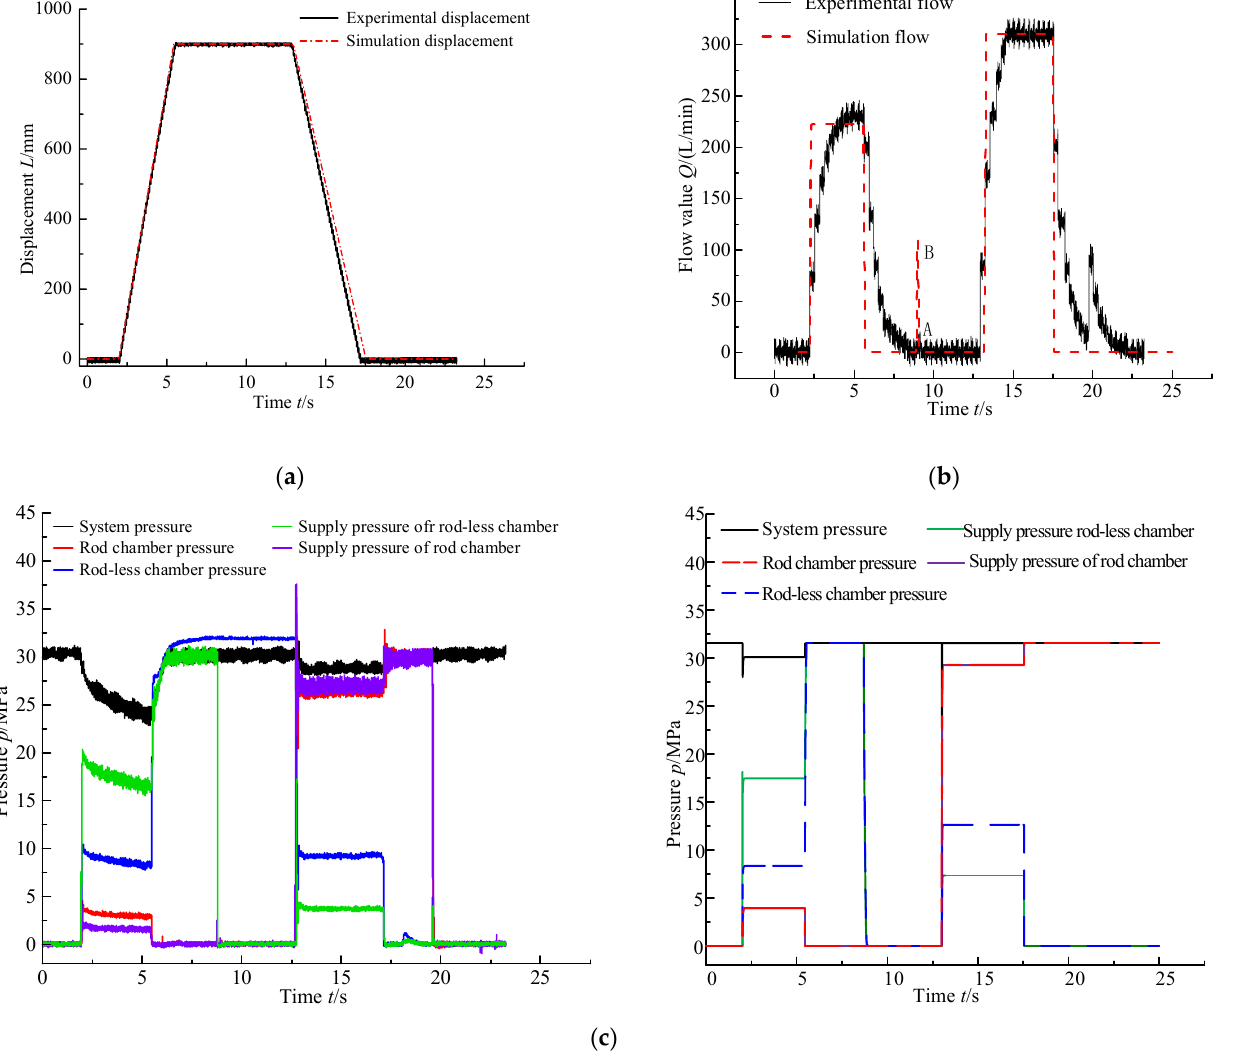
Figure 6. Comparison of the test and simulation data under 31.5 MPa system pressure: ( a ) Comparison diagram of experiment and simulation displacement; ( b ) comparison diagram of experiment and simulation outlet flow of electro-hydraulic control directional valve; ( c ) comparison diagram of experiment and simulation pressure.